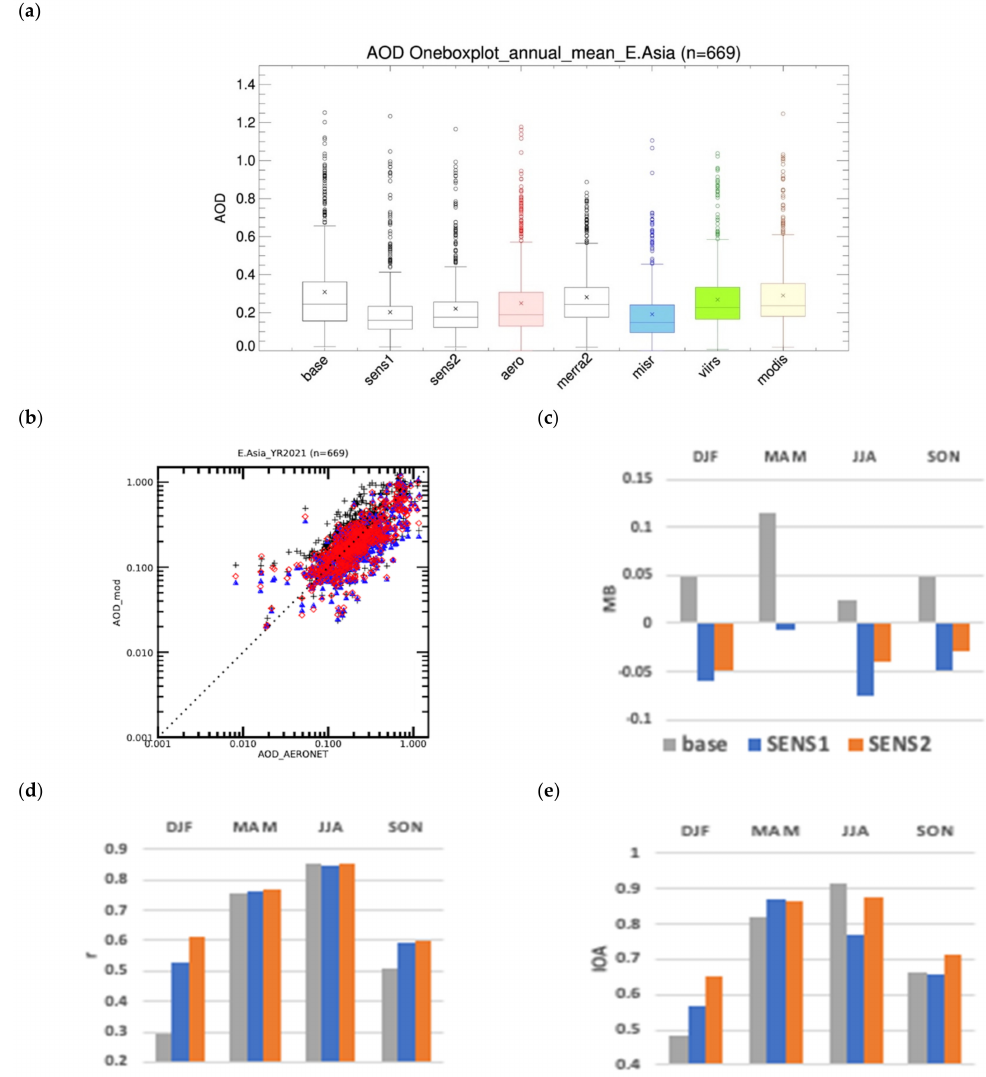
Figure 12. ( a ) The box and whisker plot of the annual AOD mean biases of BASE, SENS1 , and SENS2 (first, second, and third column in white, respectively); AERONET (in pink); MERRA2 (5th column in white); MISR (in light blue); VIIRS (in green); and MODIS (in yellow) in East Asia. ( b ) The scatter plot of annual simulated AODs against AERONET AODs (the 1:1 dotted line is inset). ( c ) Seasonal mean biases, ( d ) seasonal correlations, and ( e ) seasonal